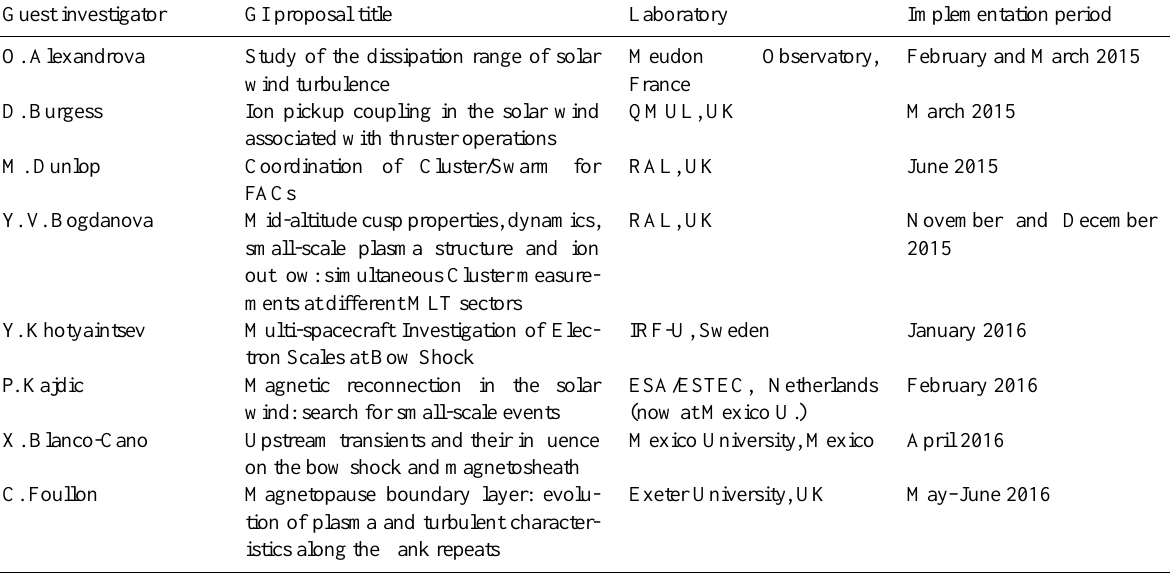
Table 3. List of Cluster guest investigators selected in 2014. Guest